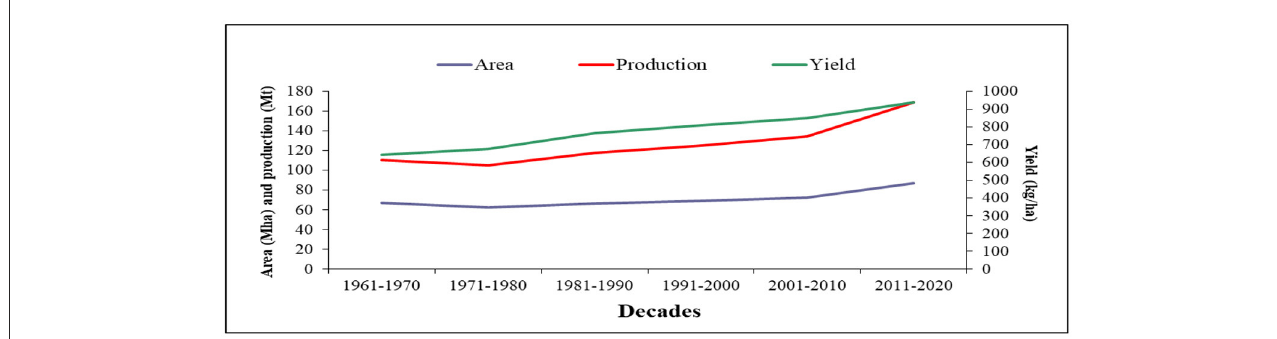
FIGURE2 Decadal change in the area, production, and average yield of pulses over the globe (Data sources: FAOSTAT, 2022).